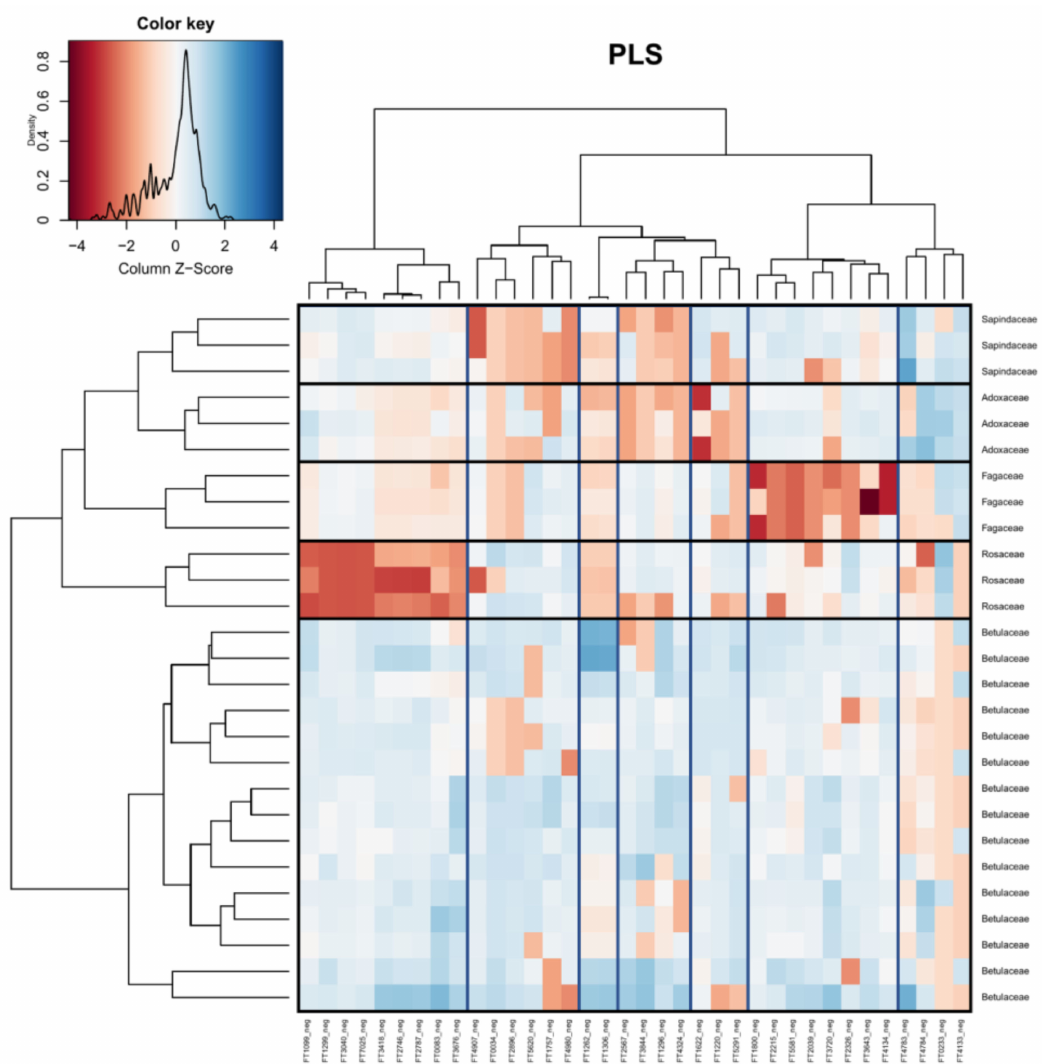
Figure 6. Heatmap visualizing the PLS of the compound table at the level of sample host tree (family). Boxes have been added for clarity (vertical = feature grouping, horizontal = sample grouping). Red indicates that peak intensities were low, while blue indicates that peak intensities were